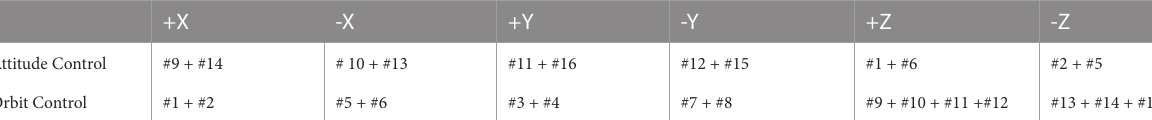
TABLE1 ThrusterconfigurationcorrespondingtoSTC.